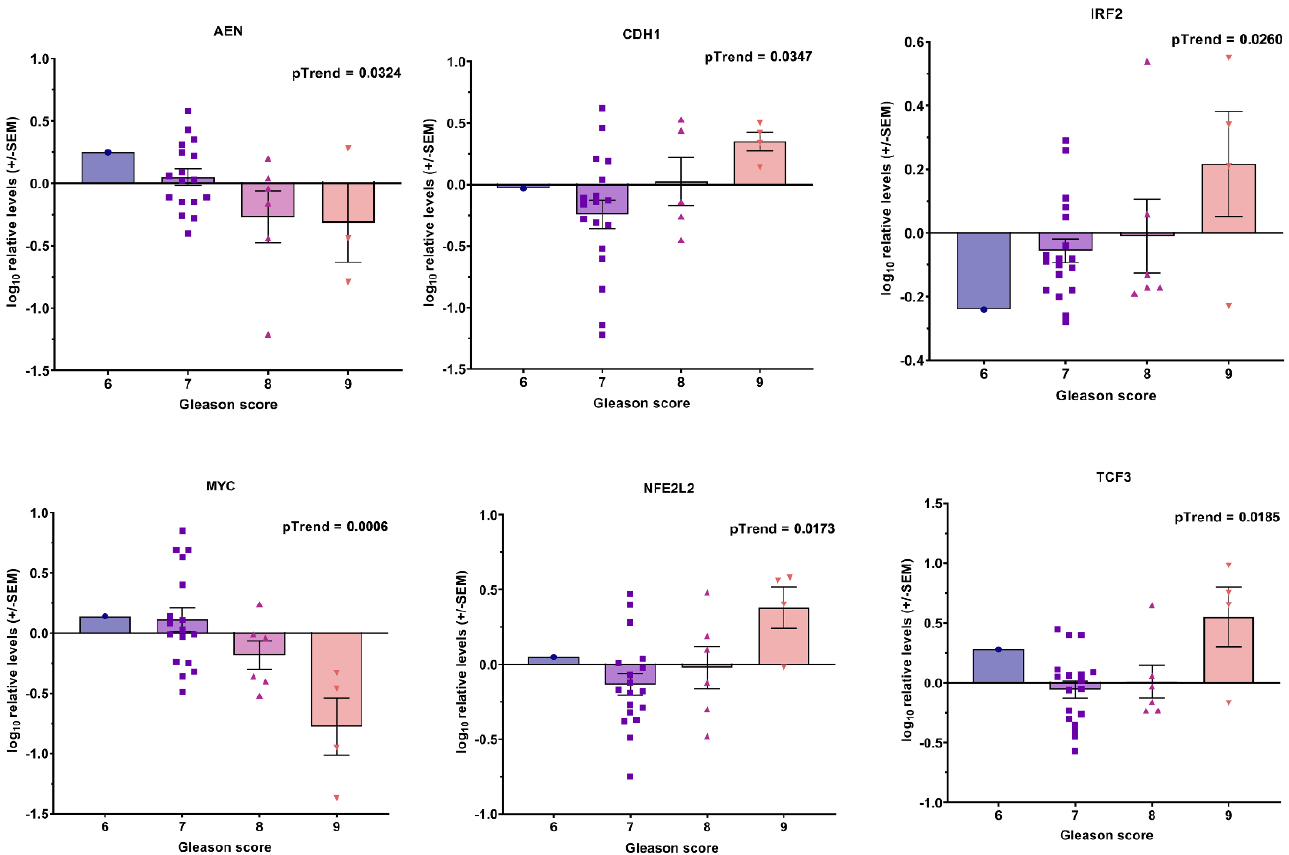
Figure 7. Associations between transcripts’ expression in blood-derived mRNA and Gleason score in ADT − cohort. Bar graphs showing − log10 relative expression levels of gene transcripts in different Gleason score groups. p values are indicated after linear test for trend following ANOVA.